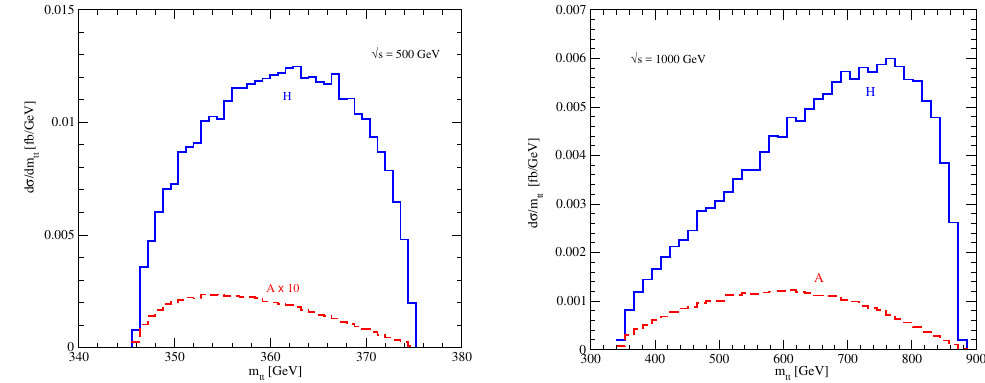
Figure 5 . The leading-order total cross section for e + e (cid:0) and CP-odd ( h = A ) limits. (cid:27) ( Ht (cid:22) t ) and (cid:27) ( At (cid:22) t ) are shown by black solid and red dotted curves respectively, and their ratio R = (cid:27) ( At (cid:22) t ) =(cid:27) ( Ht (cid:22) t ) is given by green dashed line.